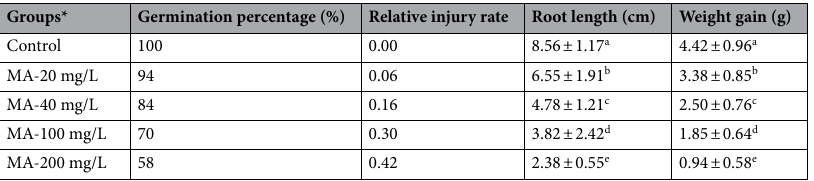
Table 1. Effects of metaldehyde treatments on physiological parameters. The means shown with different superscript letters (a–e) in the same column were significant at p < 0.05. MA metaldehyde. *Data were shown as mean ± SD. 50 bulbs were used for germination percentage and 10 bulbs were used for root length and weight gain.